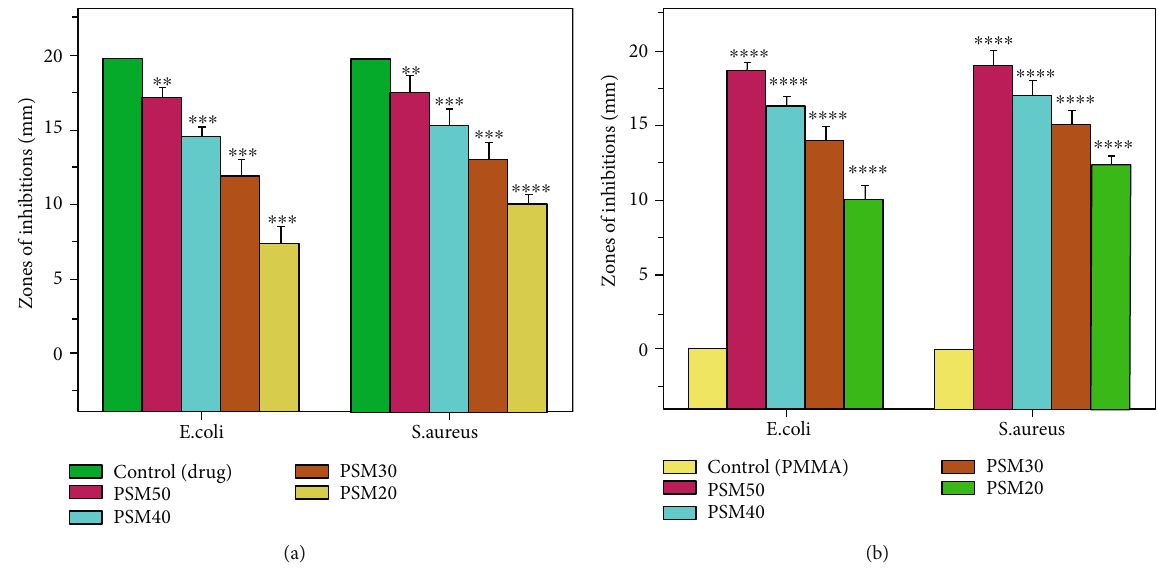
Figure 7: Zones of inhibition of PSM50, PSM40, PSM30, and PSM20 for E. coli and S. aureus : (a) with drug (+ive control) and (b) with PMMA (-ive control).